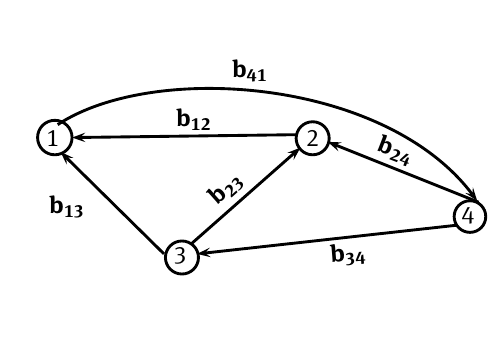
1, 2, 3, 4 and six edges. It is noted that ˇ G is strongly { }